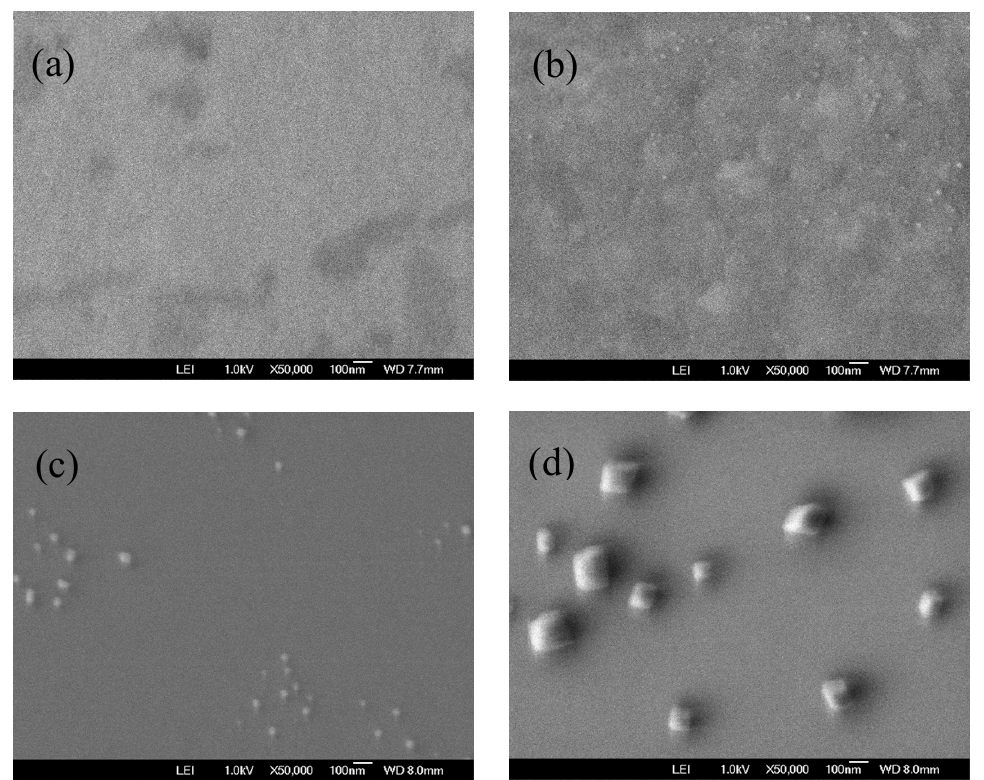
Figure 5. Scanning electron microscopy (SEM) images of ZrO 2 thin films at different temperatures of annealing: ( a ) 250 °C ( b ) 350 °C, ( c ) 450 °C, and ( d ) 550 °C. In the images, the white bars at the bottom indicate 100 nm.